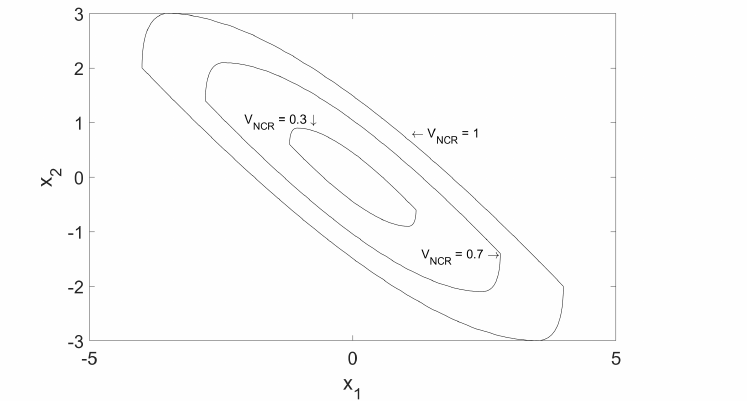
Figure 1. Level sets created using the boundary of the NCR for a MIMO linear system.